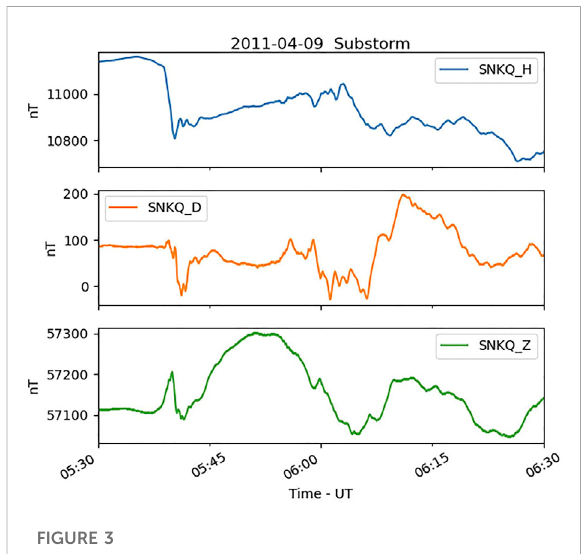
FIGURE 3 ExampleofasimpleplotproducedusingPandasbuiltinplotting functionality highlighting a substorm observed by the SNKQ ground- based magnetometer station loaded using the themis module.